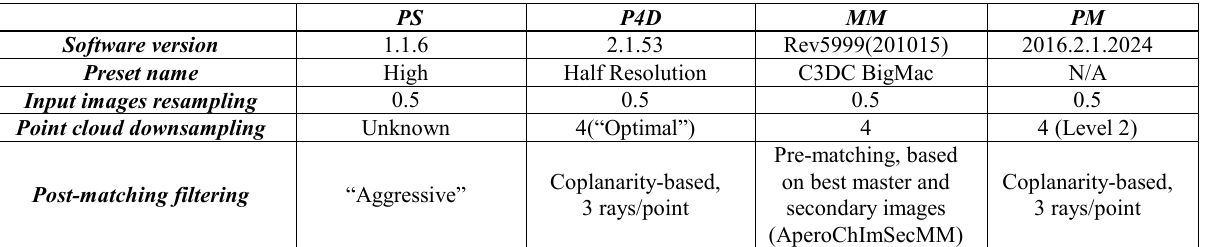
Table 5. Dense matching settings for the Phantom 3 data set.